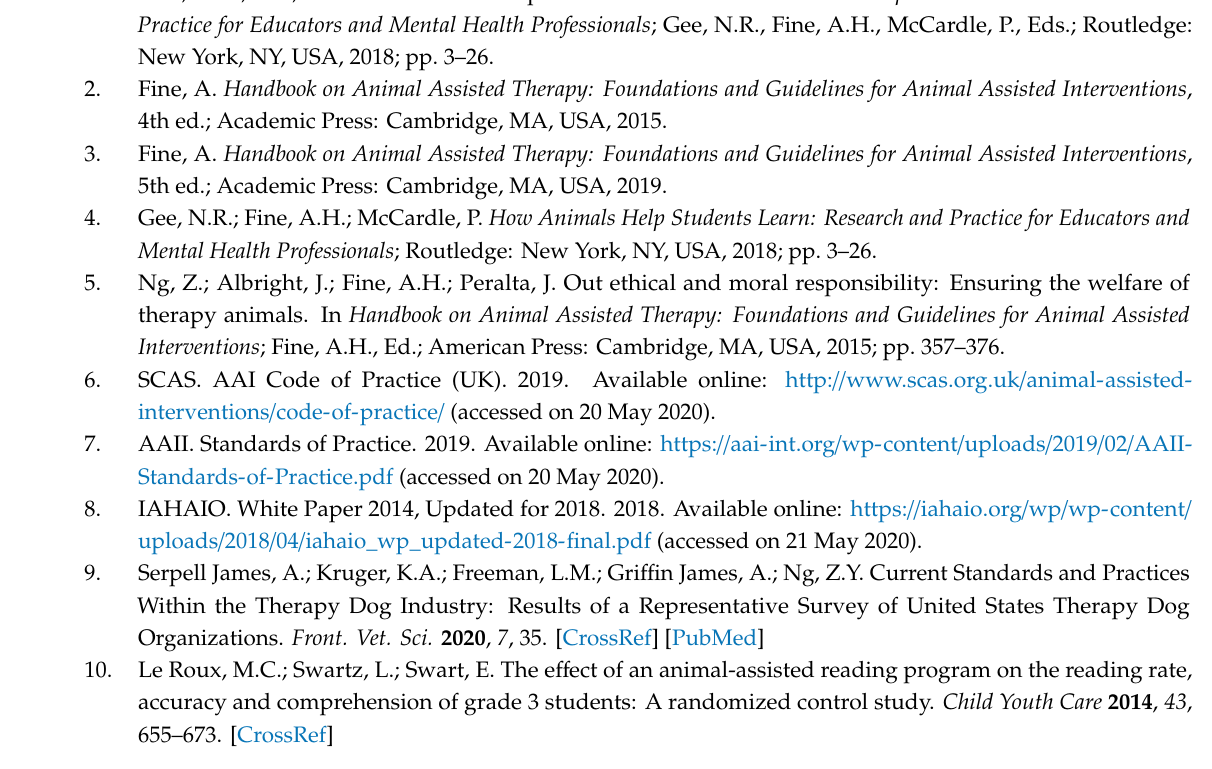
Table S1: Risk Assessment Tool for dog-assisted interventions in Schools and Educational Settings, Table S2: Risk Assessment Tool for dog-assisted interventions in Other Settings; Table S3: Dog Care